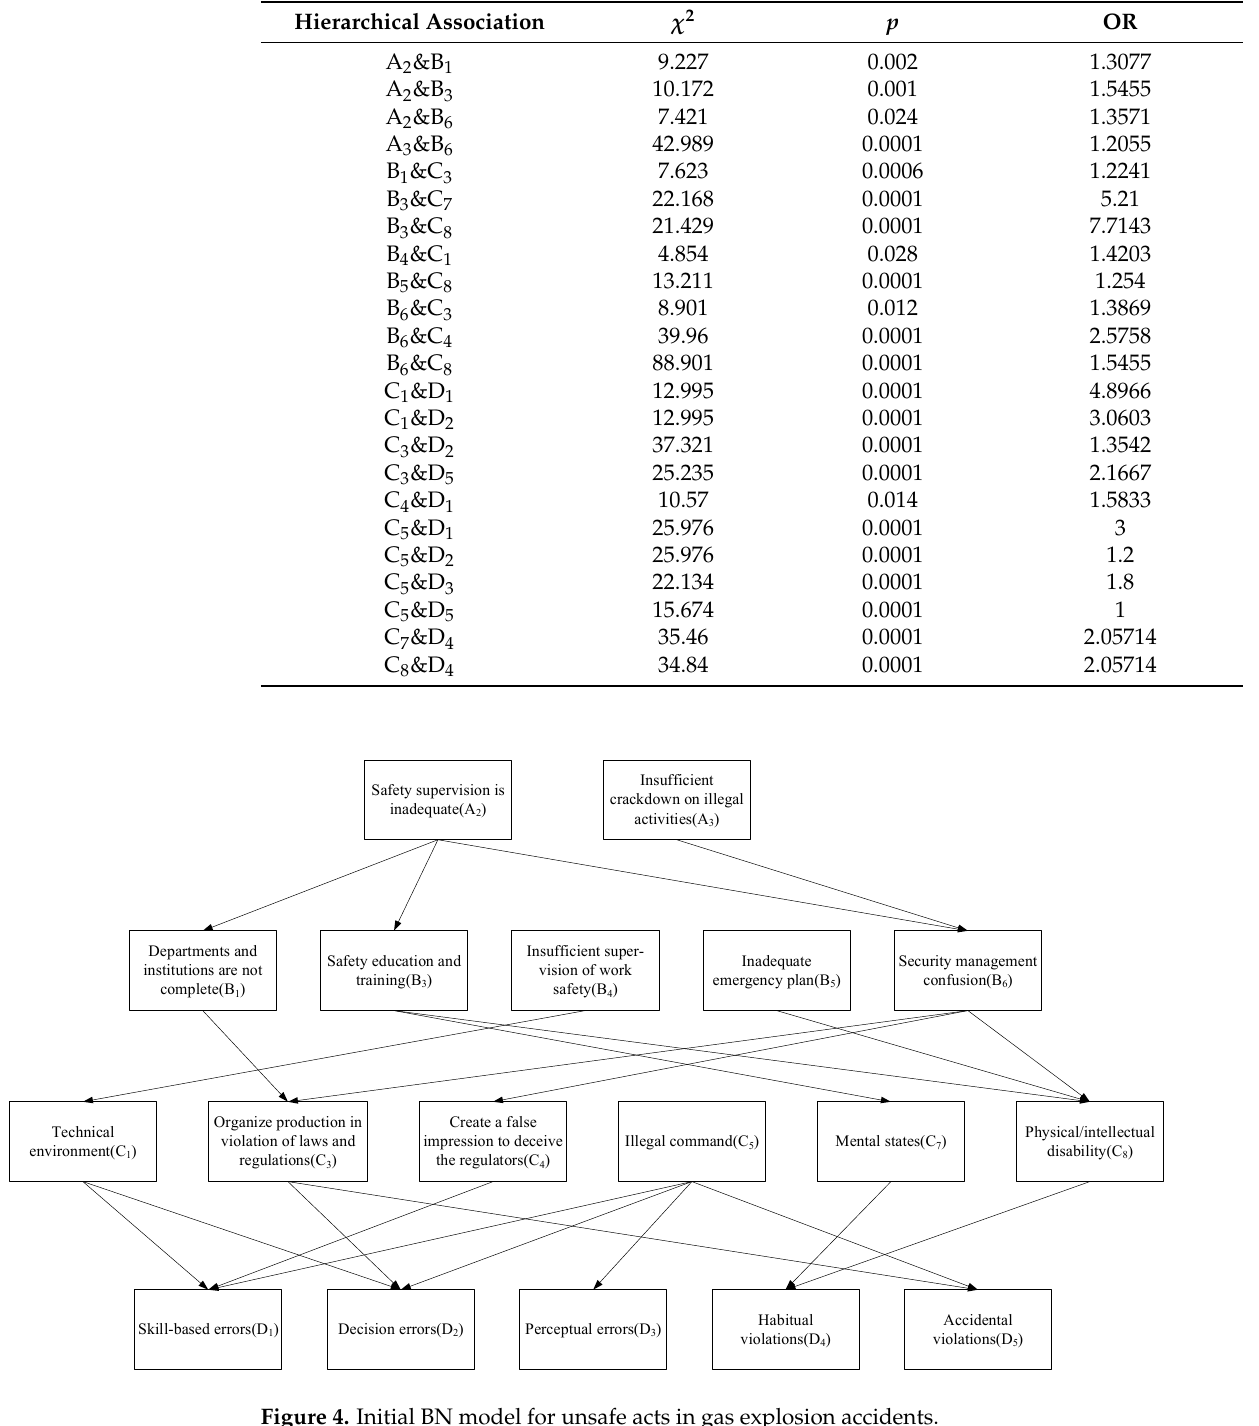
Table 6. Probability of five root nodes.